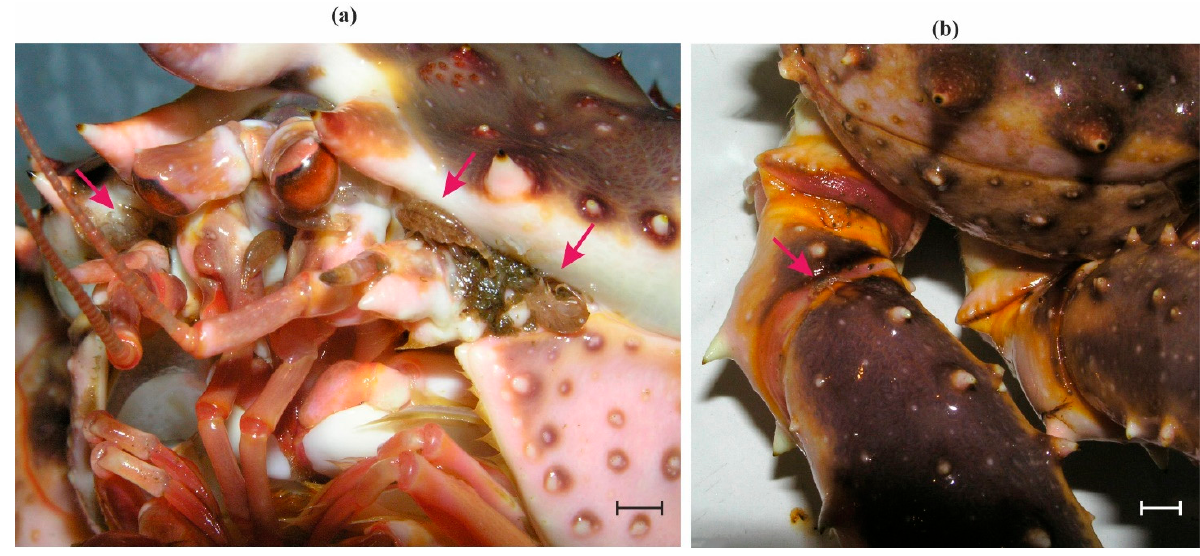
Figure 1. Ischyrocerus commensalis amphipods (arrows) on the mouthparts ( a ) and limbs ( b ) of red king crabs from Dalnezelentskaya Bay, July 2022. Scale bar 5 mm.